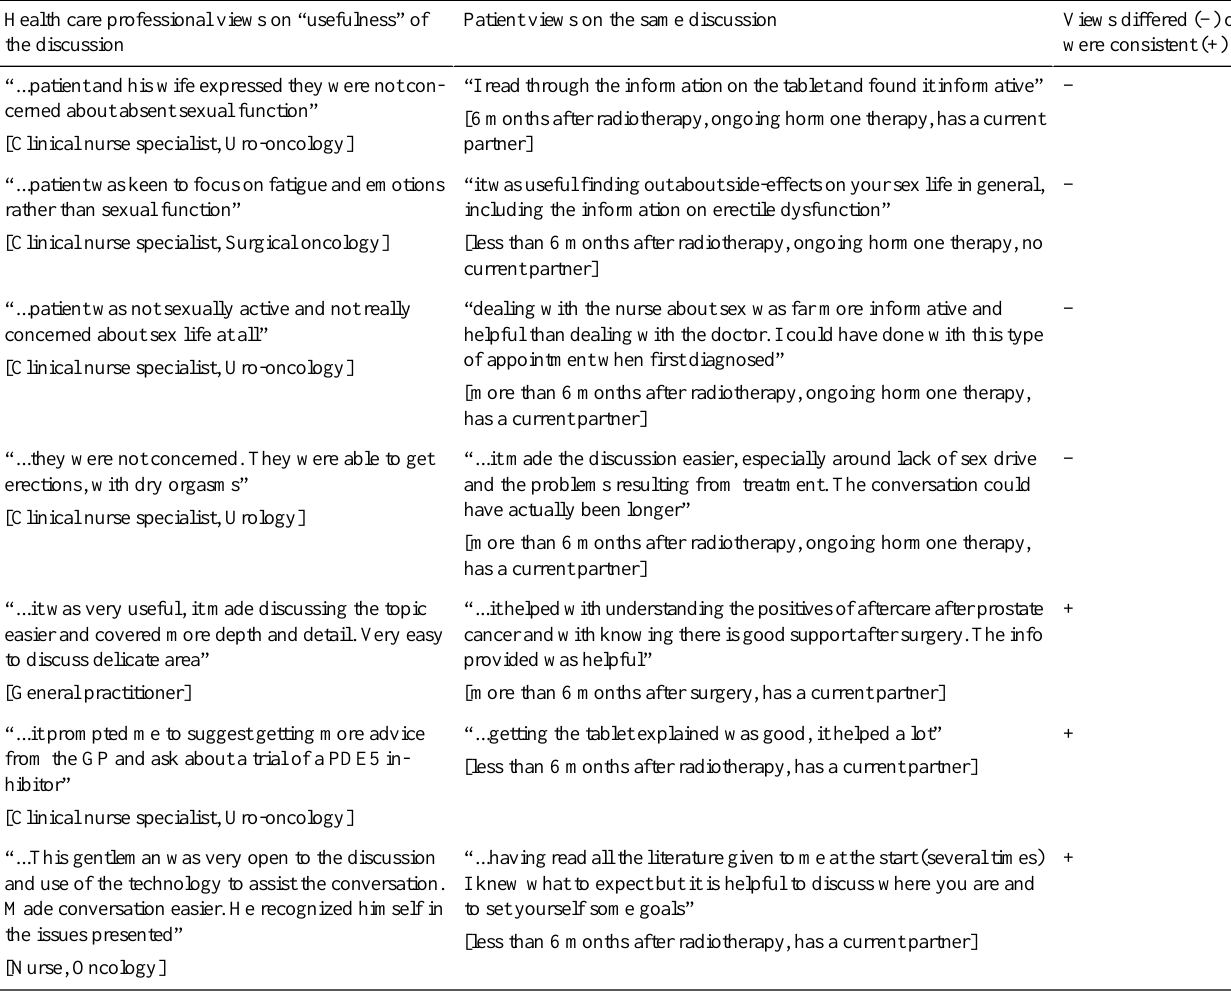
Table 1. Examples from individual appointments demonstrating where the perspectives of health care professionals and patients on “usefulness” of the EASSi tool differed or were consistent.